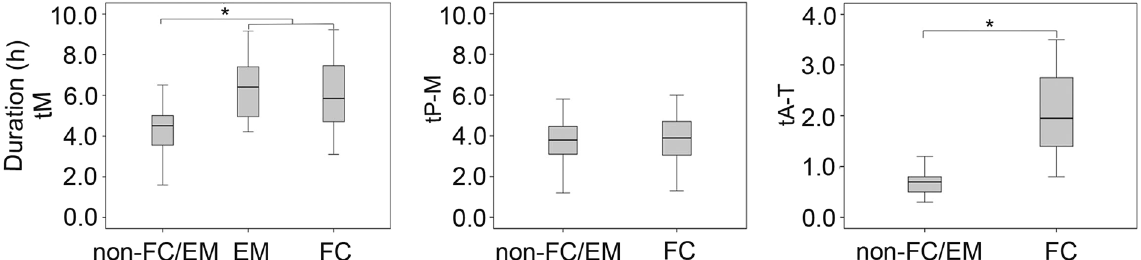
Figure 5. The duration of M phase of the 1st cell cycle between FC/EM and non-FC/EM HPs. HPs: haploid parthenotes, FC: failed cytokinesis, EM: endomitosis; tM: the duration of the disappearance of the pronucleus to the reappearance of the nucleus; tP-M: the duration of the disappearance of the pronucleus to the initiation of cytokinesis; tA-T: the duration of the initiation of cytokinesis to complete cytokinesis and the reappearance of the nucleus. An asterisk indicates a significant difference by a t-test (P <